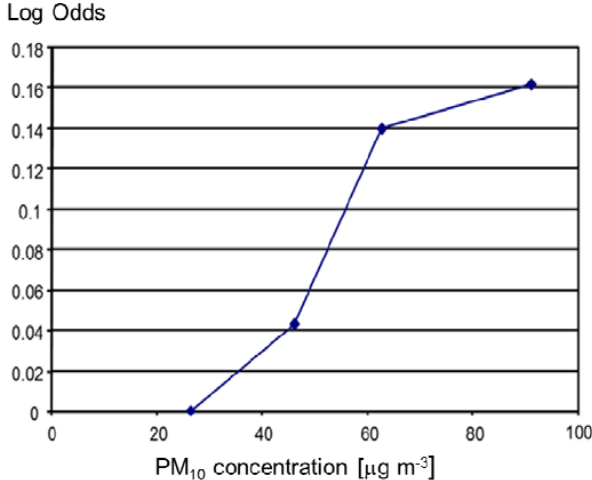
Fig. 5. Natural logarithm of the odds ratio (log odds) of asthma incidents versus categories of Dailymean PM 10 concentrations (µgm − 3 ). Categories are defined by quartiles of PM 10 and rep- resented by the median PM 10 within the